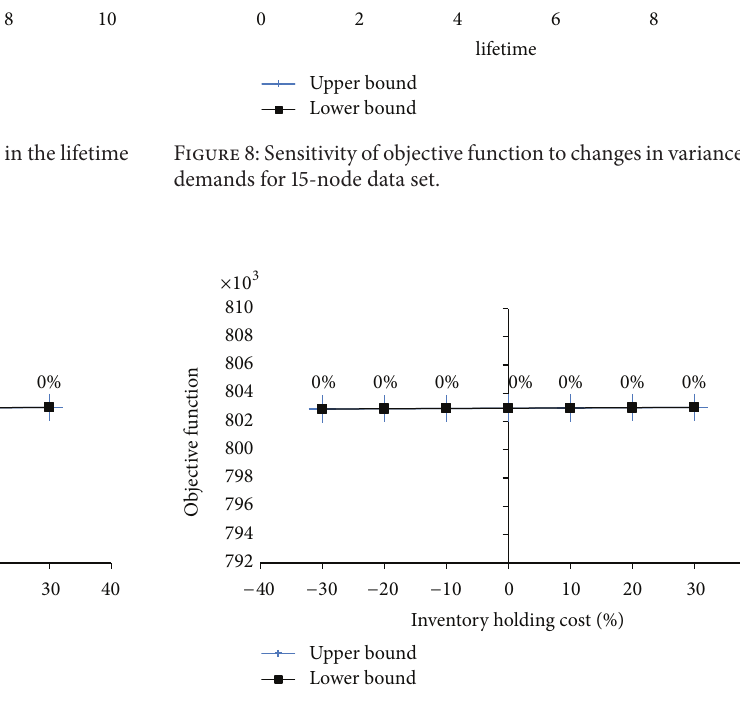
Figure 9: Sensitivity of objective function to changes in variances of demands for 49-node data